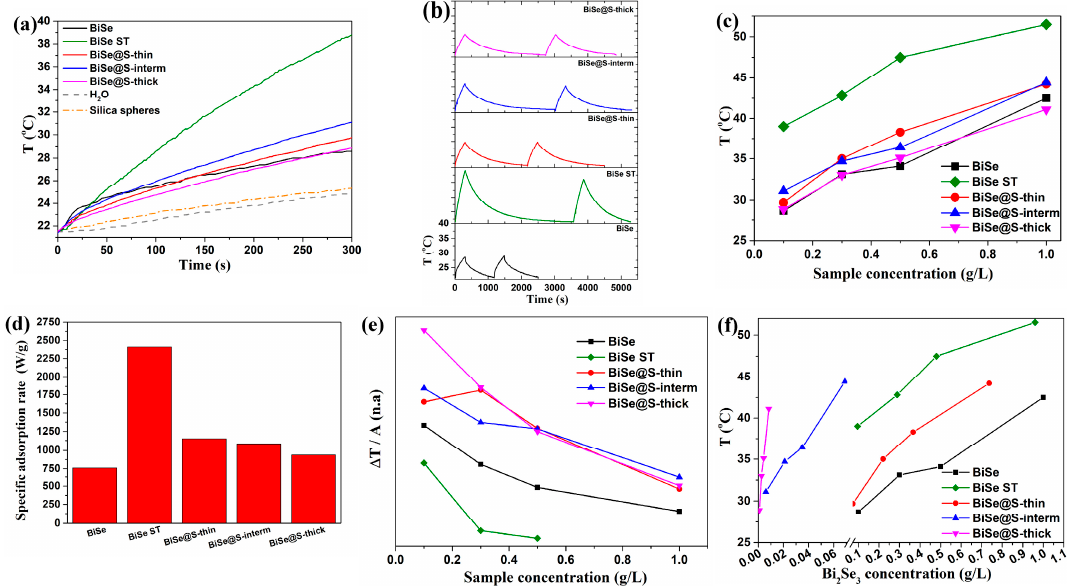
Figure 4. Temperature increase of the particle solution with 0.1 g/L ( a ) and corresponding heating and cooling cycles ( b ). Final T reached after 5 min laser exposure at different concentrations ( c ), specific adsorption rate (SAR) ( d ) and efficiency of adsorbed light conversion into heat represented as ∆ T/A for different concentrations ( e ). Final temperatures after 5 min laser exposure vs. concentration of the photo-thermal active particles in the sample ( f ). The experiments were conducted with laser light of 808 nm and P = 3 W/cm 2